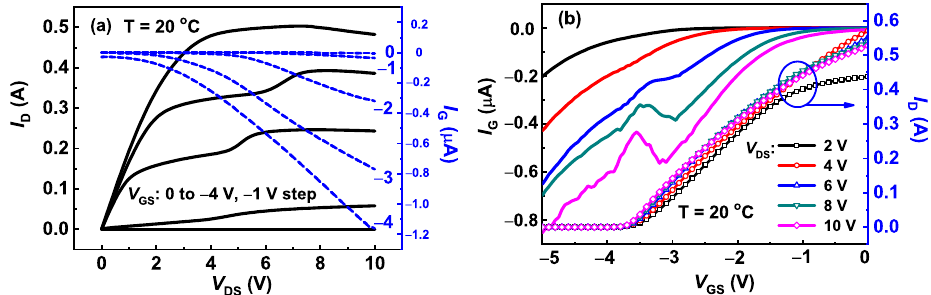
Figure 1. Room-temperature ( ∼ 20 ◦ C) output ( a ) and I G - V GS ( b ) characteristics of the fabricated HEMTs with L G /L GS /L GD /W G = 0.35/1.25/2.4/800 µ